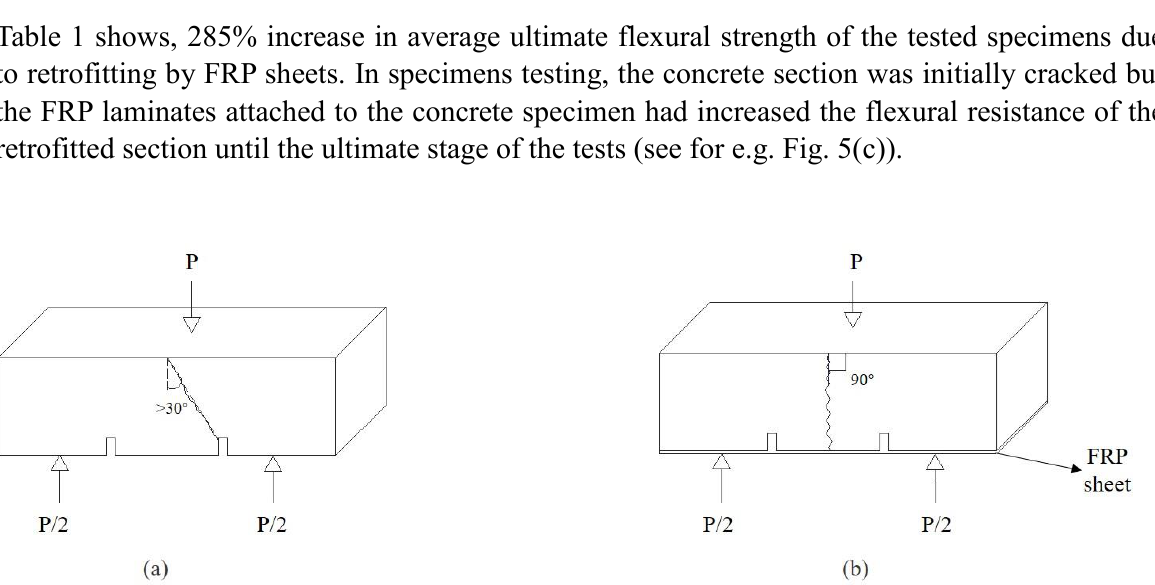
Fig. 4. Fracture (crack line) for a) un-retrofitted specimen b) Retrofitted